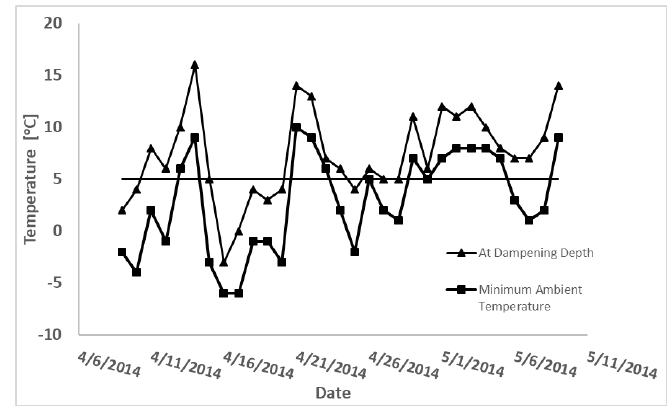
Figure 6. Typical variation of temperature experienced by early hatchlings at the soil surface (ambient) and at the dampening depth.